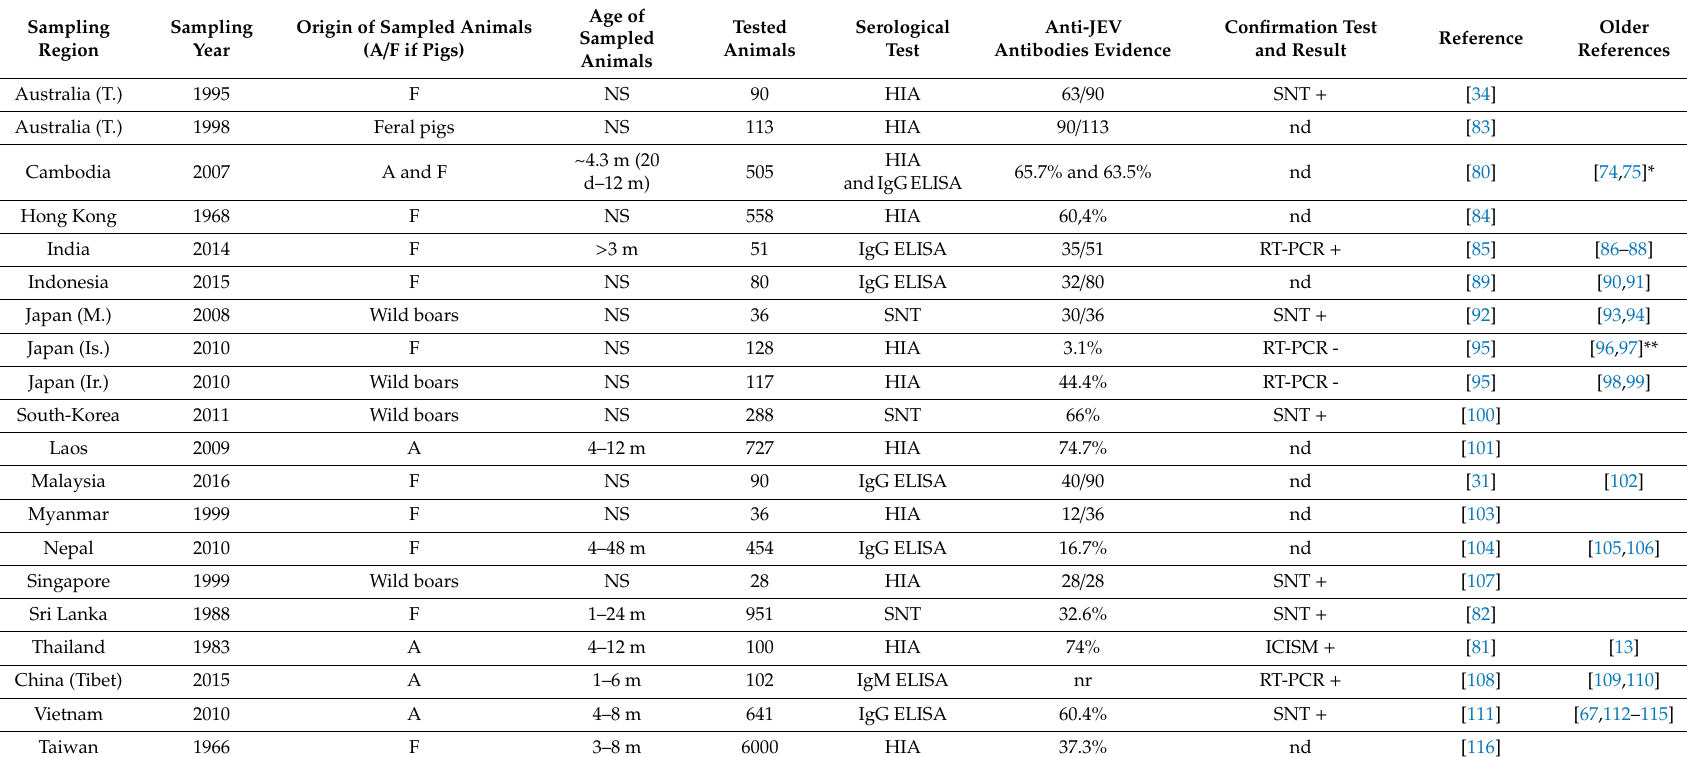
Table 6. Detection and seroprevalence of JEV in swine in the